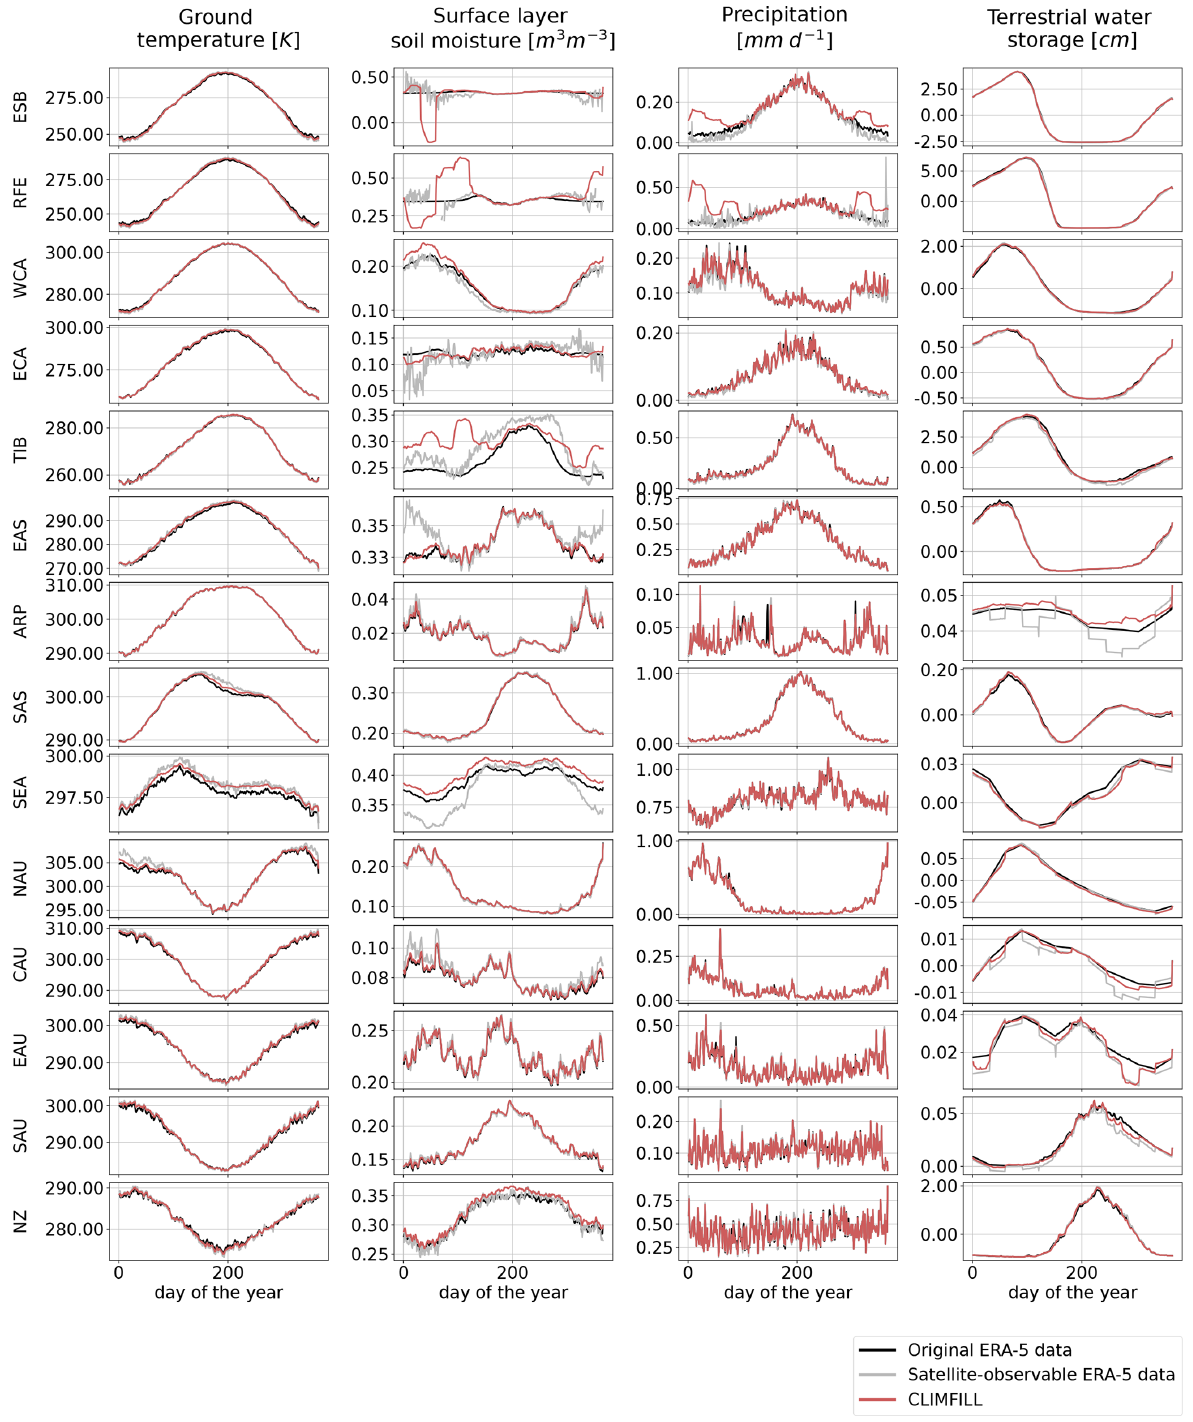
Figure A4. Figure A2